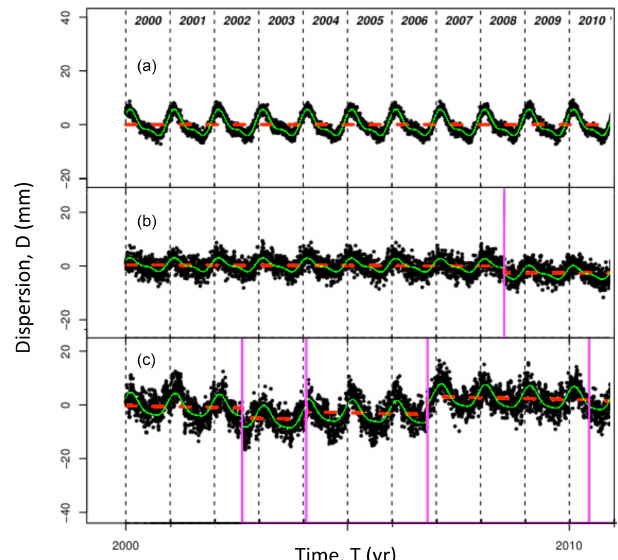
Figure 3. Examples of synthetic time series. Black dots represent daily positions. Green, red, and pink lines show modeled seasonal signal, velocity and offsets. The three examples illustrate the qual- ity of the data used in our study: (a) a slightly noisy series ( k = − 0 . 3, D = 1 . 2mm) without offset; (b) a moderately noisy series ( k = − 0 . 4, D = 2 . 3mm) with 1 offset; (c) a noisy series ( k = − 0 . 7, D = 3 . 5mm) with multiple